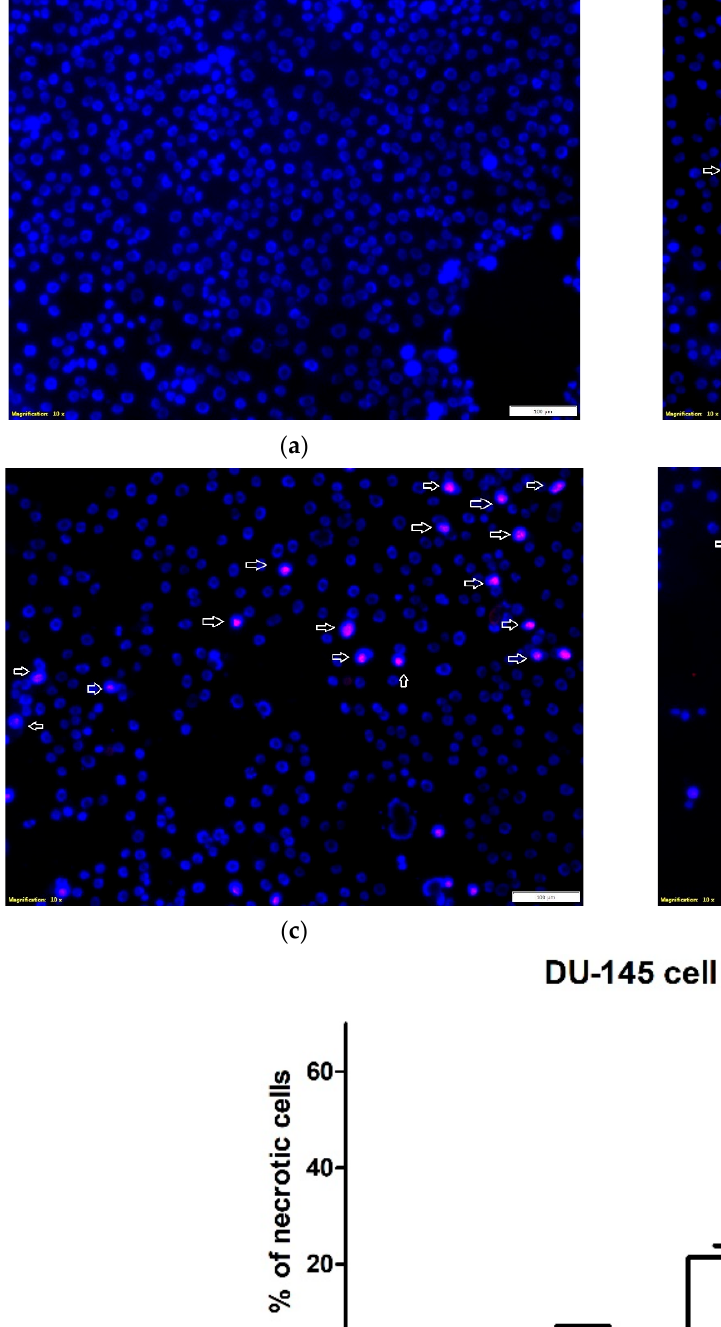
Figure 4. Effects of the tested extracts on the induction of PC-3 cell death: ( a ) control; ( b ) cisplatin at 25 µg/mL; ( c ) 80% extract at 25 µg/mL; ( d ) 75% extract at 25 µg/mL. Propidium iodide (red) and Hoechst 33342 (blue) staining. Magnification, 10×. Necrotic cell nuclei were stained pink. The num- ber of necrotic cells per 100 PC-3 cells was assessed in three visual fields. Data are presented as means ± SDs. Significant values (*) compared with control with p < 0.05 (one-way ANOVA with Tukey’s post hoc test) ( e ).